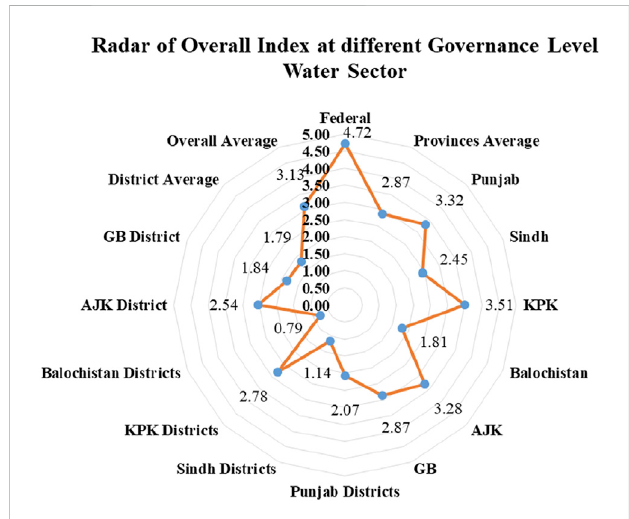
FIGURE 5 Radar showing the state of water sector governance in different